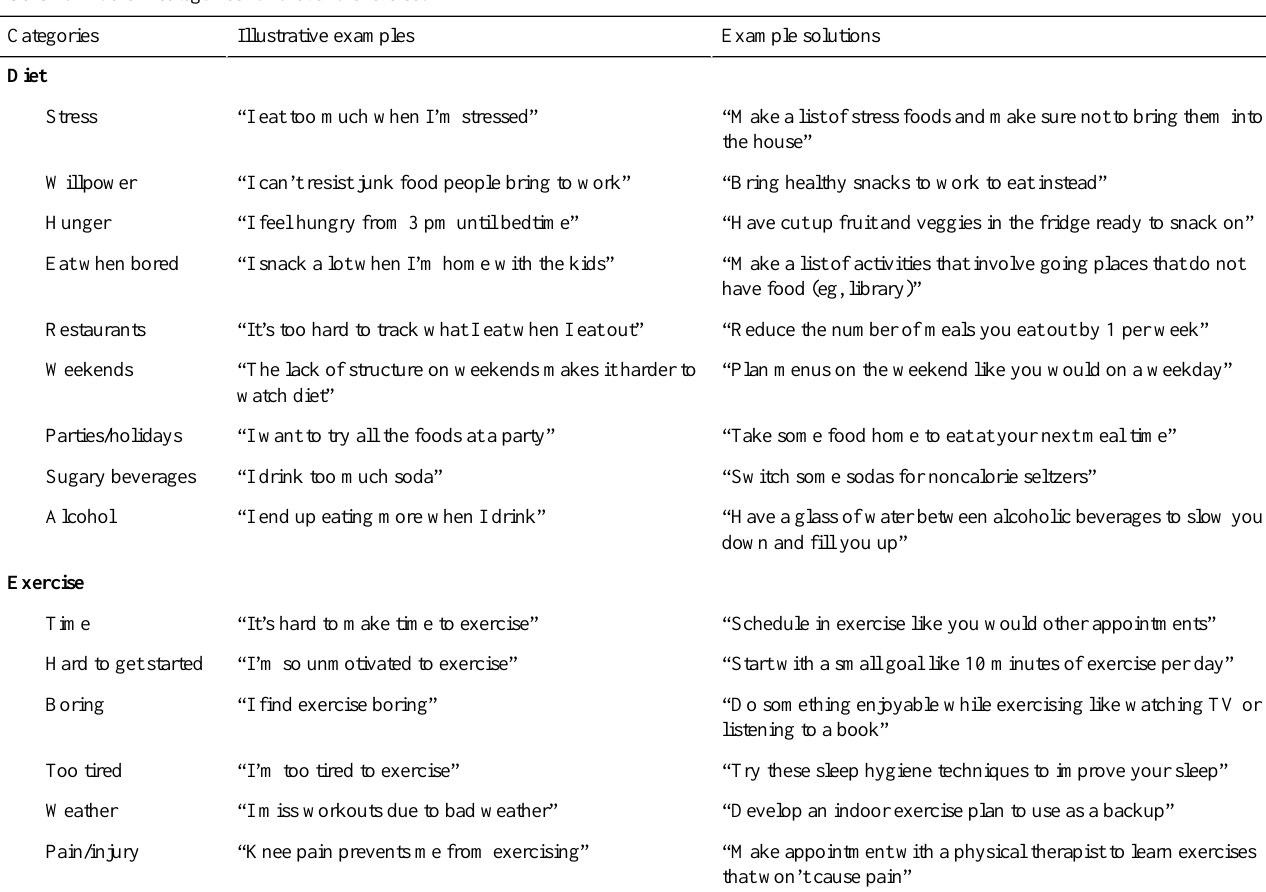
Table 1. Problem categories for diet and